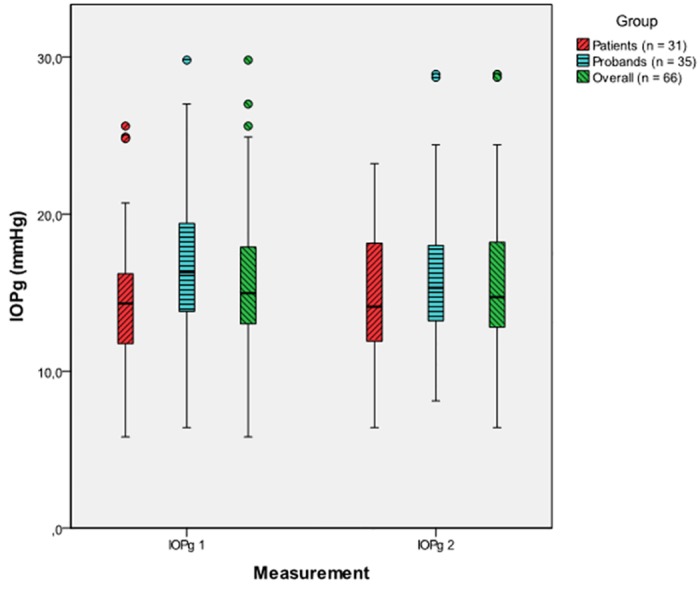
Tonographic effect from the first (IOPg 1) to the second (IOPg 2) IOPg measurement for patients, probands and the overall sample (patients and probands combined), [mmHg].